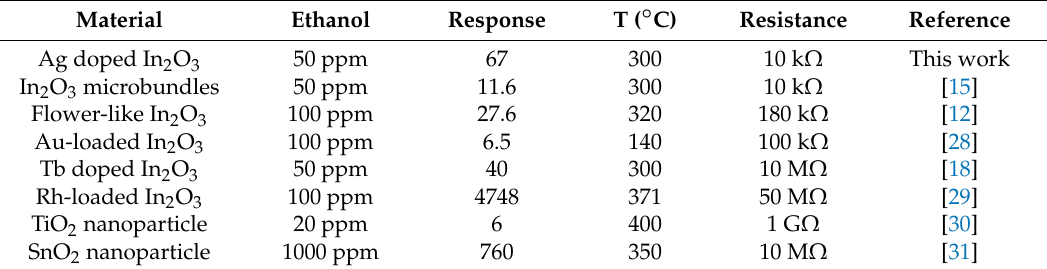
Figure 5. Responses vs operating temperatures of Ag-modified In 2 O 3 nanomaterials. Table 1. Sensing properties to ethanol and acetone of the different materials in our present study and in literature studies.